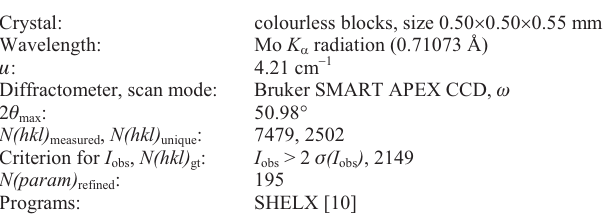
Table 1. Data collection and handling.